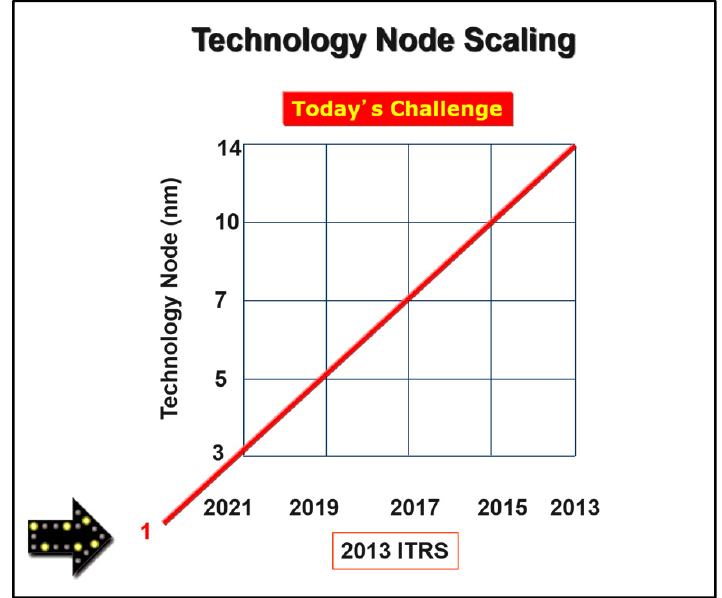
Figure 4. The past extrapolation showing that 2D scaling faced fundamental limits beyond 2020.